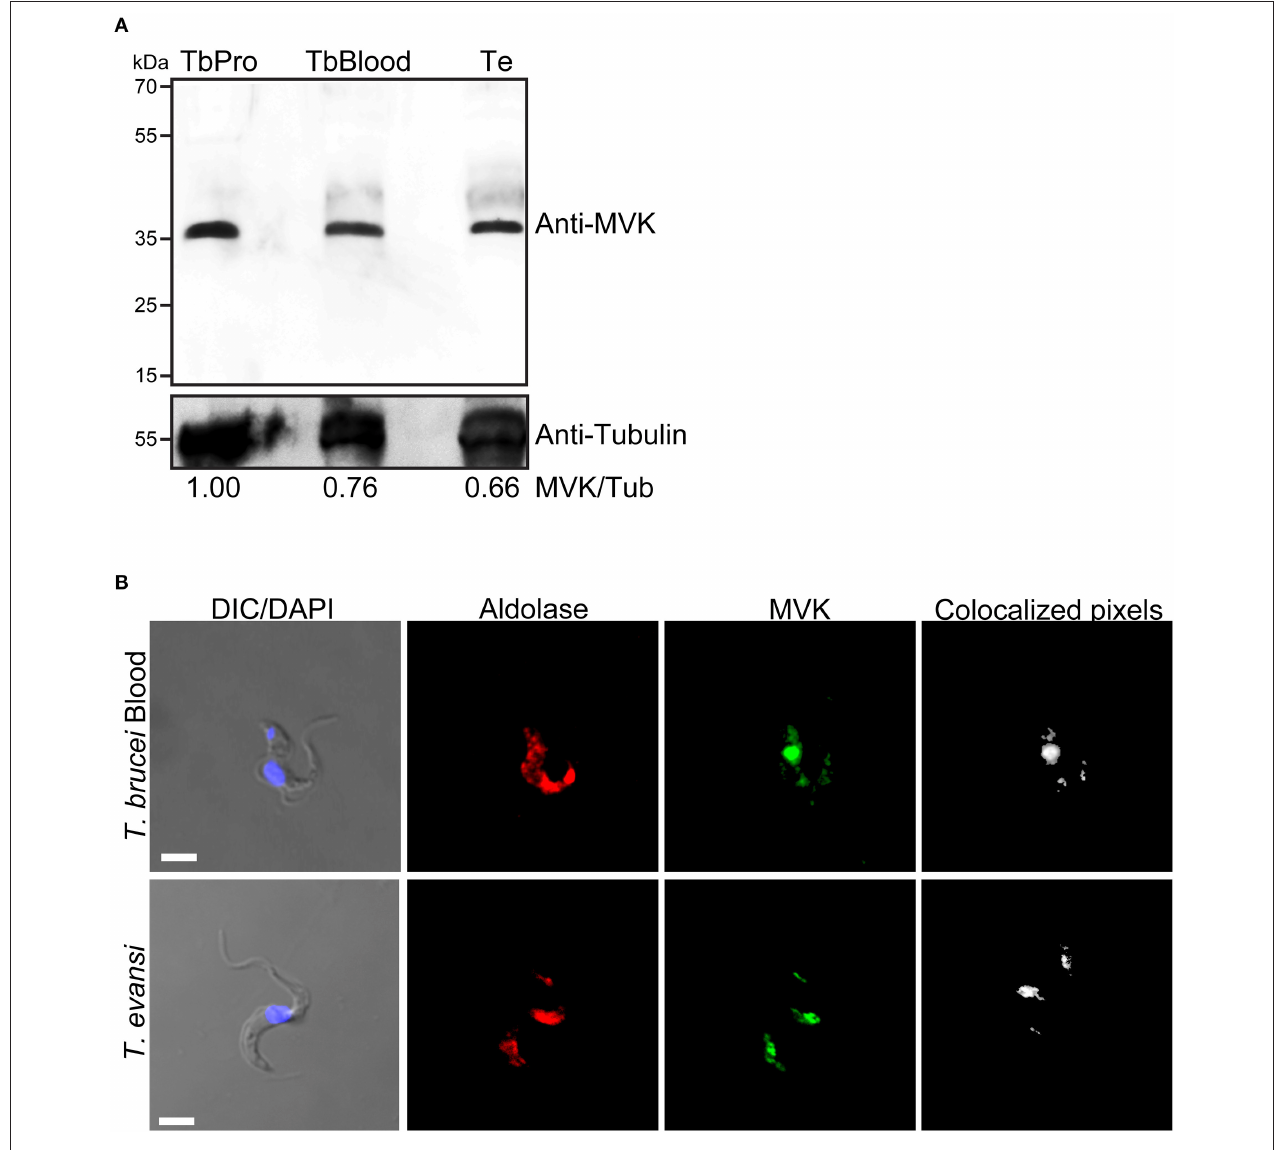
FIGURE 4 | T. evansi expresses MVK (TeMVK) in vivo , and protein is localized in glycosomes. (A) Thirty micrograms of protein extracts of T. brucei procyclic form (TbPro), T. brucei bloodstream form (TbBlood), and T. evansi (Te) were subjected to SDS-PAGE and western blotting. Anti-TcMVK antibody raised in mice reveals expression in T. evansi and T. brucei of MVKs with similar molecular weight ( ∼ 36 kDa). Anti-tubulin was used as loading control. Numbers refer to the densitometric ratio between TeMVK/tubulin. (B) Immunofluorescence using antibodies against aldolase (glycosomal marker; red) and MVK (green) reveals colocalization of the two enzymes in both T.brucei bloodstream form and T.evansi . Nuclei and kinetoplast were stained using DAPI. Images were obtained by confocal microscopy, and reconstructed using Imaris software program (Bitplane). Colocalized pixels are shown in white color. DIC, differential interference contrast. Scale bar: 3 µ